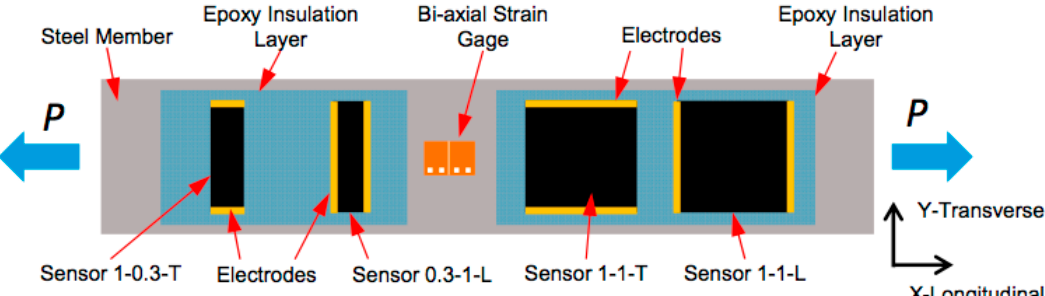
Figure 2. Uniaxial tensile test of a steel plate with longitudinal and transverse sensors. (from reference [16], with permission).